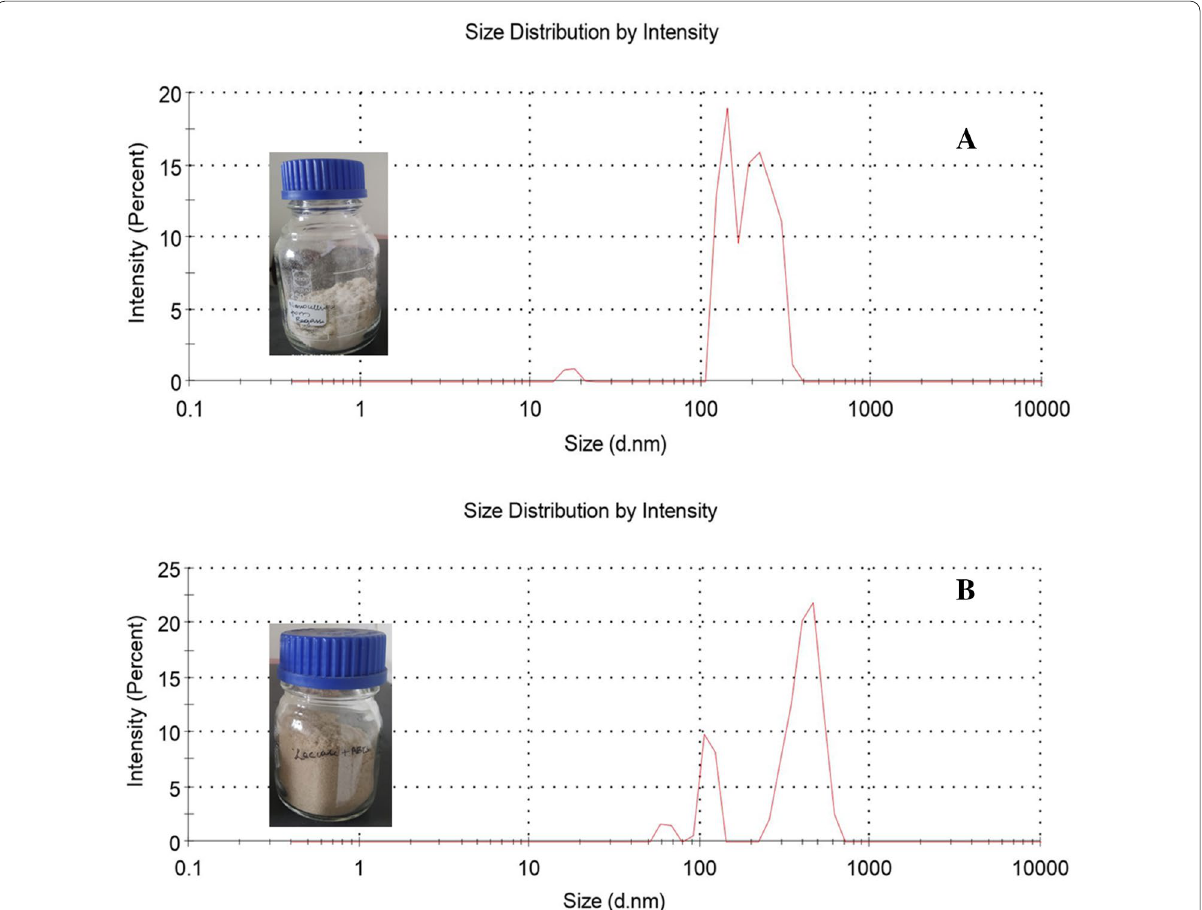
Fig. 9 Particle size analysis of nanocellulose for A laccase